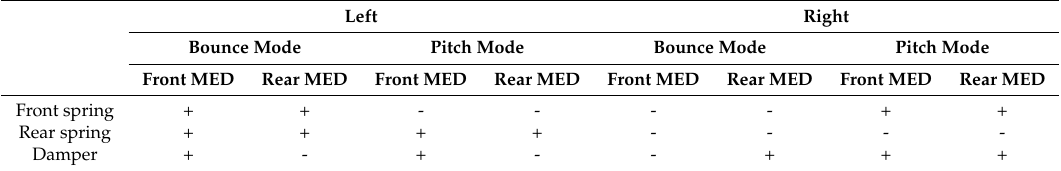
Table 3. Tendencies of stiffness and damping ratio.